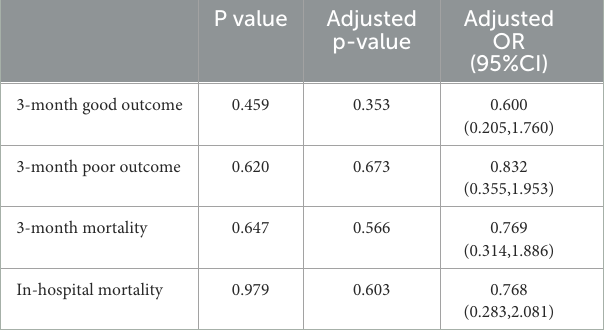
TABLE 4 Association between intravenous therapy and clinical outcomes.